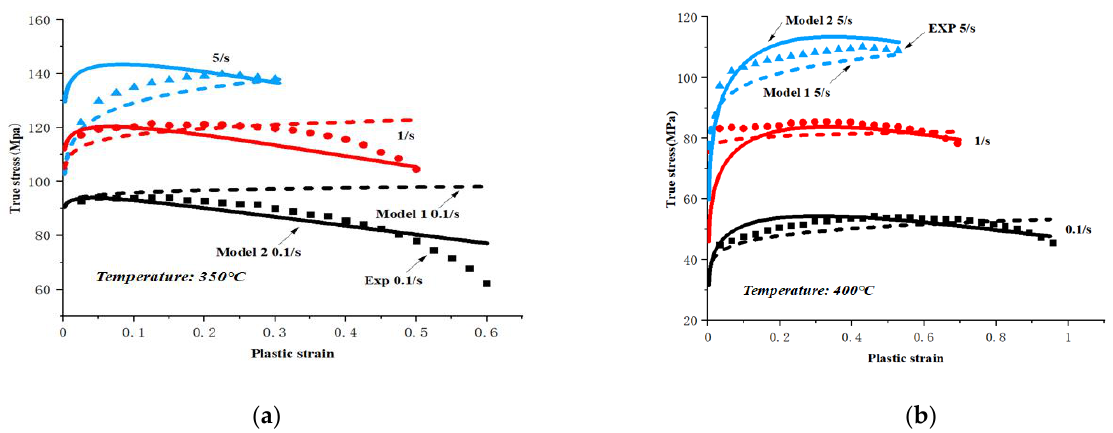
Figure 9. Comparisons of stress-strain relationships between the experiments and phenomenological fittings at ( a ) 350 °C and ( b ) 400 °C with various strain rates. Model 1 represents the classic FB model, and Model 2 represents the improved FB model.